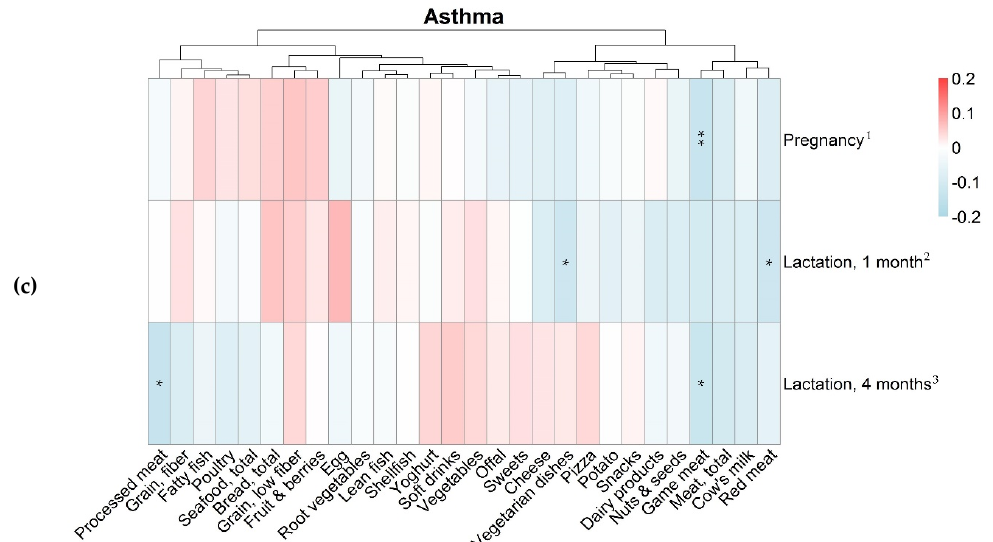
Figure 2. Heatmaps of correlations between reported maternal food intake (g per day) during pregnancy, lactation 1 month, and lactation 4 months, and o ff spring food allergy ( a ), atopic eczema ( b ) and asthma ( c ) during the first year of life. Associations between o ff spring allergy and maternal food intake were analyzed with partial Spearman’s correlation and all analyses were adjusted for any allergy within family, siblings, season of birth, and total energy intake. Definition of each dietary variable is presented in Supplementary Table S1. The magnitude of each correlation is denoted with a color, whereby red color indicates a positive correlation and blue color represents a negative correlation. Darker shades of these two colors indicate stronger correlations. Significant associations are denoted as: * p < 0.05, ** p < 0.01, and *** p < 0.001. Spearman’s rank correlation coe ffi cients and p -values for significant associations are listed in Supplementary Table S4 (confounder adjusted) and Supplementary Table S5 (crude). For associations between allergy and food intake during lactation, only mothers who were breastfeeding at 1 and 4 months, respectively, were included in the analyses. Number of included subjects in the three figures are: ( a ) 1 n tot = 409 and n allergic = 38, 2 n tot = 366 and n allergic = 34, 3 n tot = 338 and n allergic = 30. ( b ) 1 n tot = 403 and n allergic = 32, 2 n tot = 363 and n allergic = 31, 3 n tot = 335 and n allergic = 27. ( c ) 1 n tot = 402 and n allergic = 31, 2 n tot = 358 and n allergic = 26, 3 n tot = 332 and n allergic = 24.